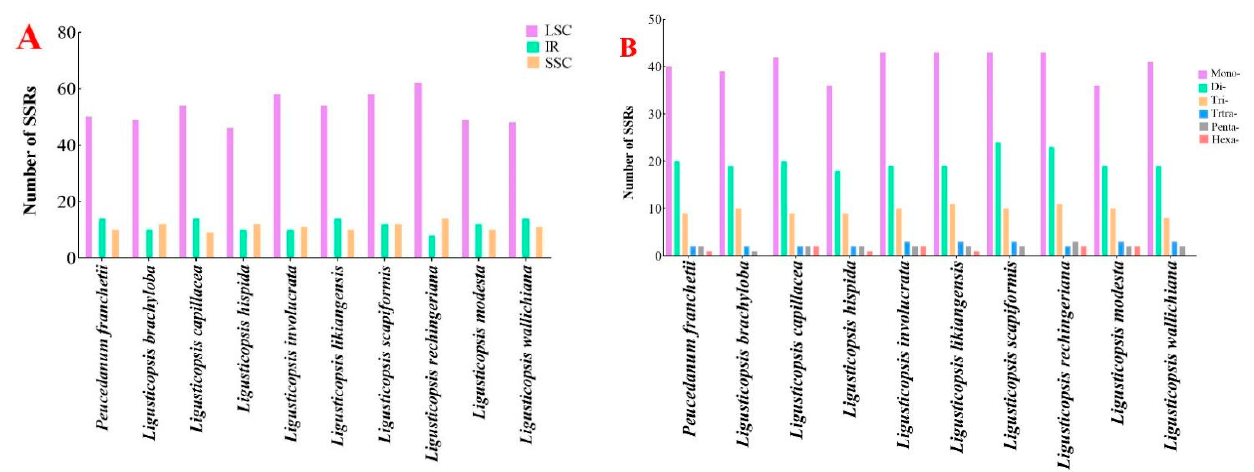
Figure 5. Analyses of simple sequence repeats (SSRs) in ten plastomes. ( A ) Presence of SSRs in LSC, SSC and IR; ( B ) numbers of different repeat types.